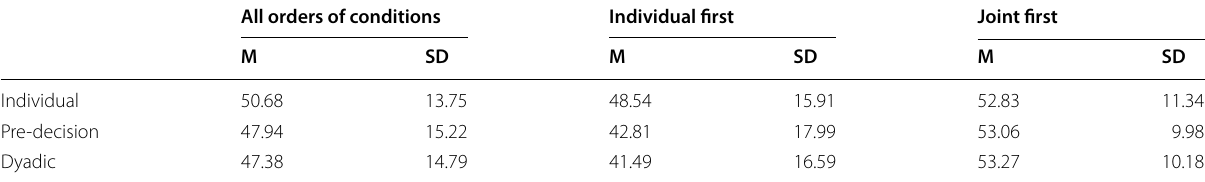
Table 1 Descriptive statistics: percentage of SS choices in % All orders of